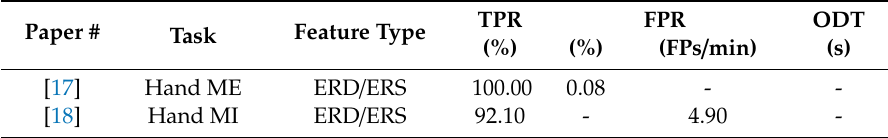
Table 7. List of electrocorticography (ECoG)-based brain-switch